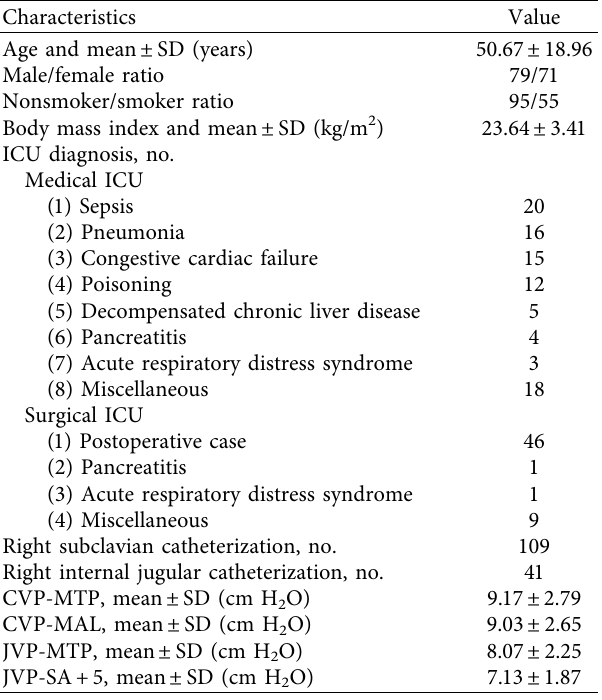
Table 1: Characteristics of 150